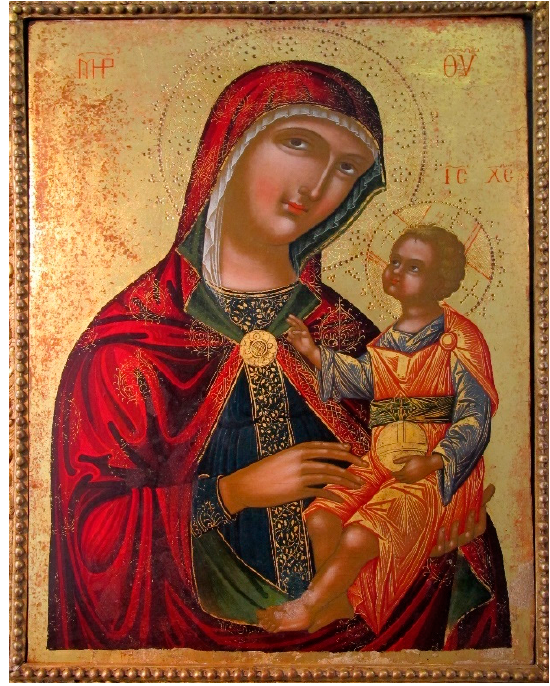
Figure 7. Ioannes Permeniates (attr.), Madonna and Child , San Marino, Museo di Stato (photograph by the author).